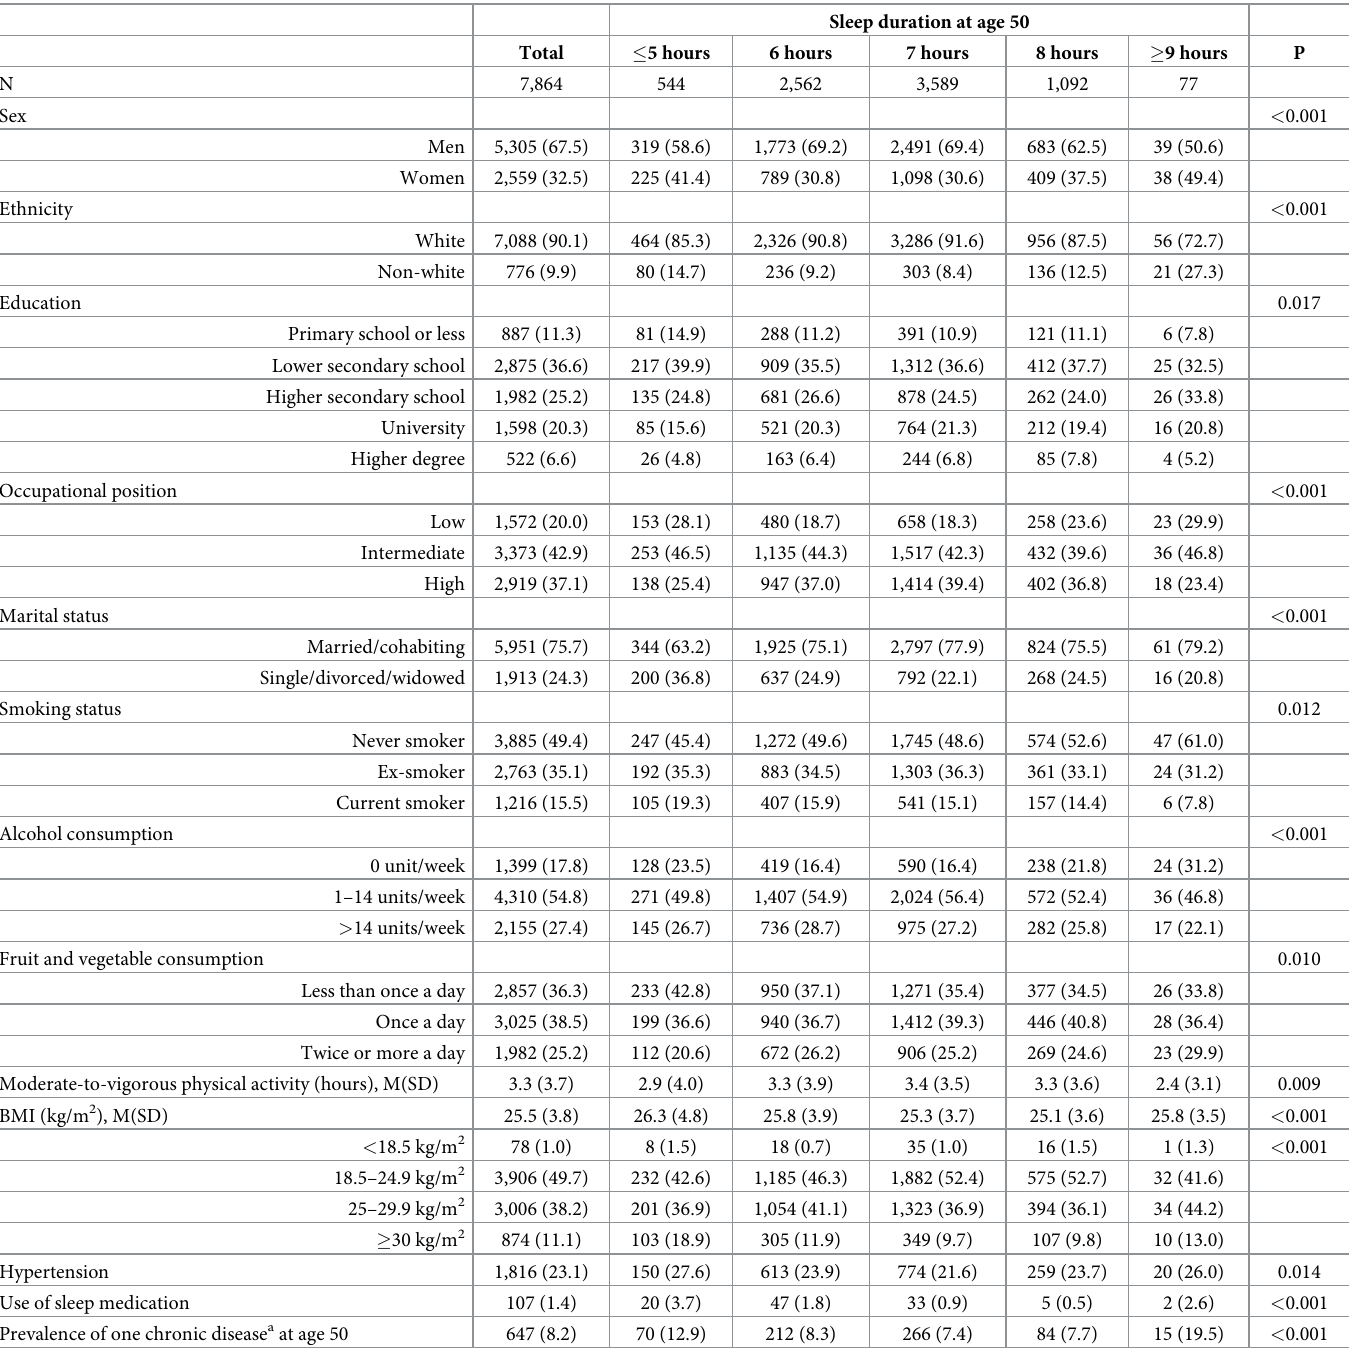
Table 1. Characteristics of the study population at age